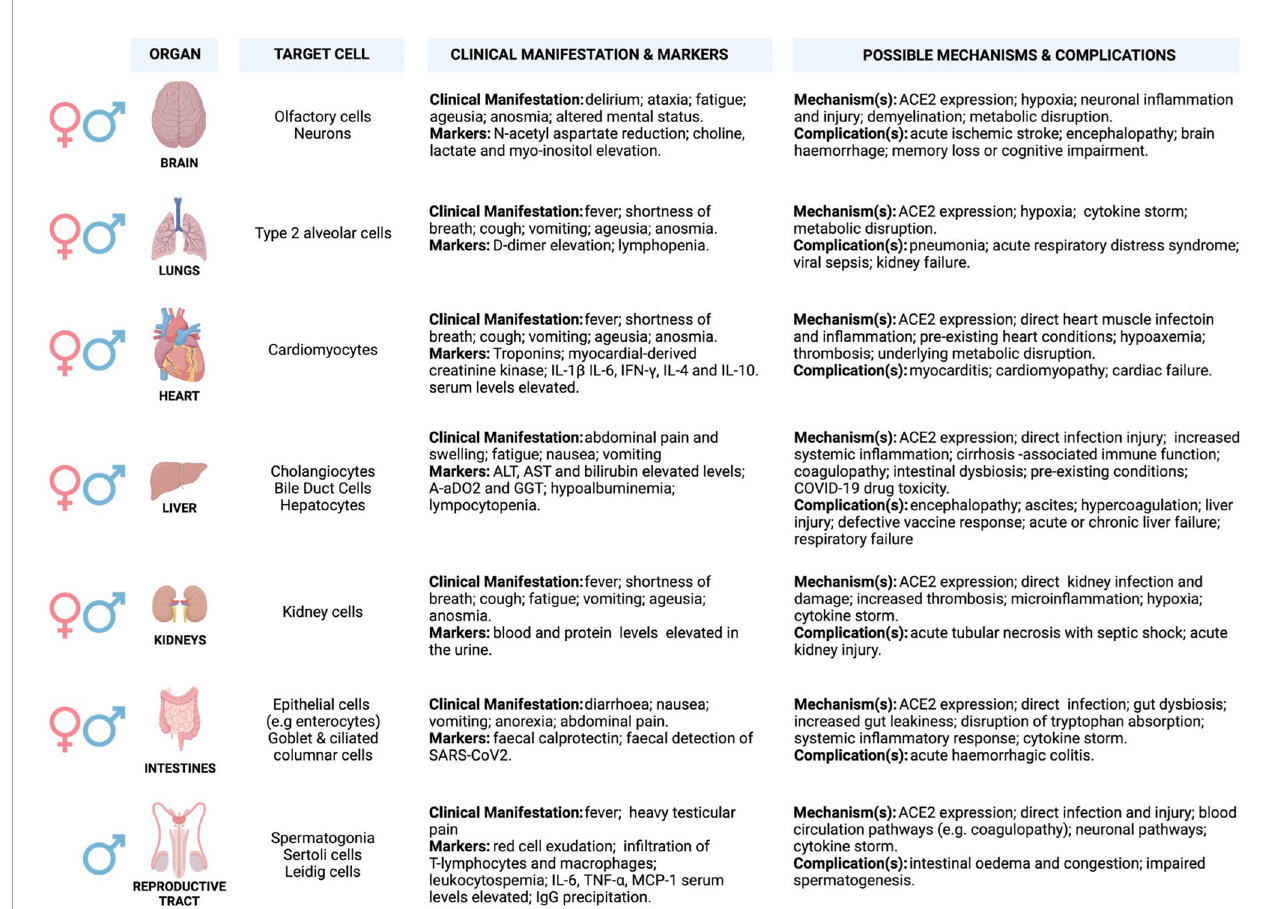
FIGURE 2 | Potential underlying mechanisms of SARS-CoV2 invasion and multi-organ induced damage. In fl ammation mediated by SARS-CoV-2 infection and its primary receptor ACE2 drive multi-organ failure in severe COVID-19 cases. ACE2 is widely expressed in multiple organs, and its suppression may aggravate COVID-19 severity and negatively impacts multiple organs via regulation of RAS. Moreover, this leads to severe cases of COVID-19 that are often associated with ARDS and increased mortality rate, partially mediated by the overproduction of pro-in fl ammatory cytokines (cytokine storm). Cytokine storm results from increased levels of in fl ammatory mediators, endothelial dysfunction, coagulation abnormalities, and in fi ltration of in fl ammatory cells into the organs. This may be characterised by elevated levels of interleukin-6 (IL-6), nuclear factor kappa B (NF k B), and tumour necrosis factor-alpha (TNF a ) released from SARS-CoV-2- infected macrophages and monocytes. The involvement of different organs in severe patients is characterised by multi-organ failure and a broad spectrum of haematological abnormalities and neurological disorders that lengthen the hospitalisation duration and increase mortality. The most important mechanisms are related to the direct and indirect pathogenic features of SARS-CoV2 infection. (Created with BioRender.com). ACE2, Angiotensin I-converting enzyme-2; AoDO2, First alveolar-arterial oxygen gradient; ALT, Alanine aminotransferase; AST, Aspartate aminotransferase; IFN- g , Interferon-gamma; IL-1 b , Interleukin- 1 b ; IL-4/6/10, Interleukin- 4/6/10; TNF- a , Tumour necrosis factor-alpha; MCP-1, Monocyte chemoattractant